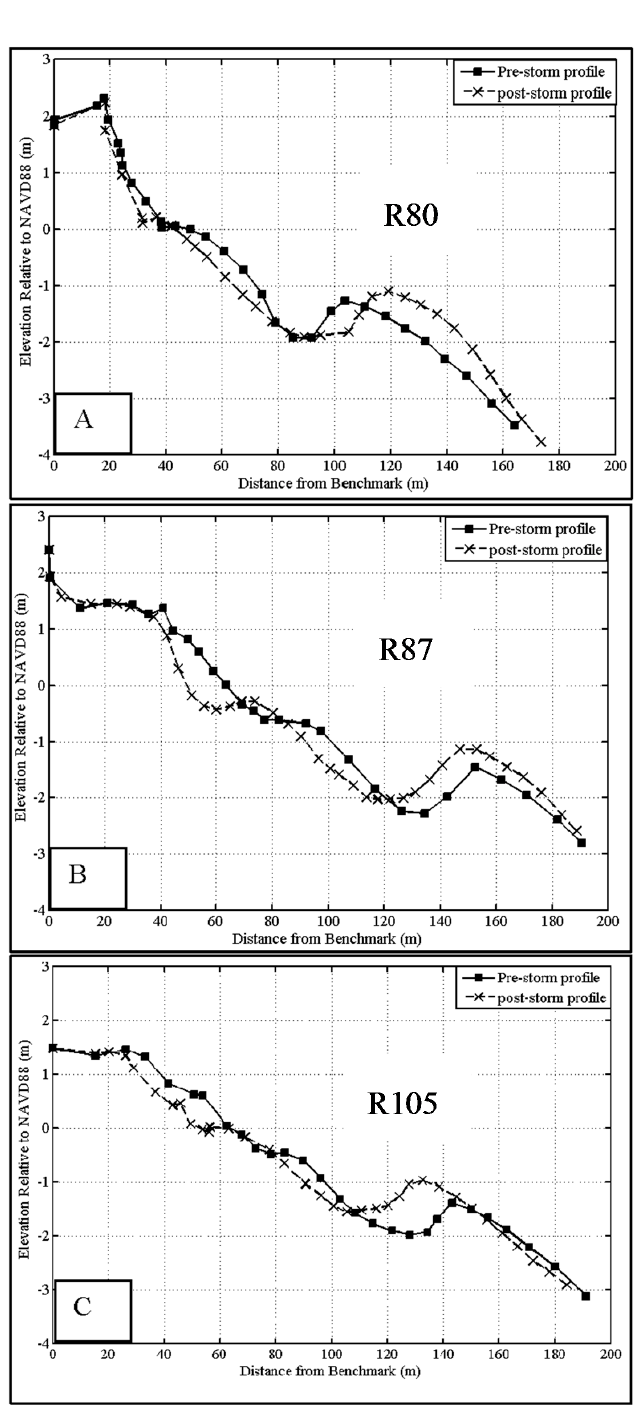
Figure 10. Pre- and post-storm surveyed beach profiles at ( A ) R80; ( B ) R87; and ( C ) R105.